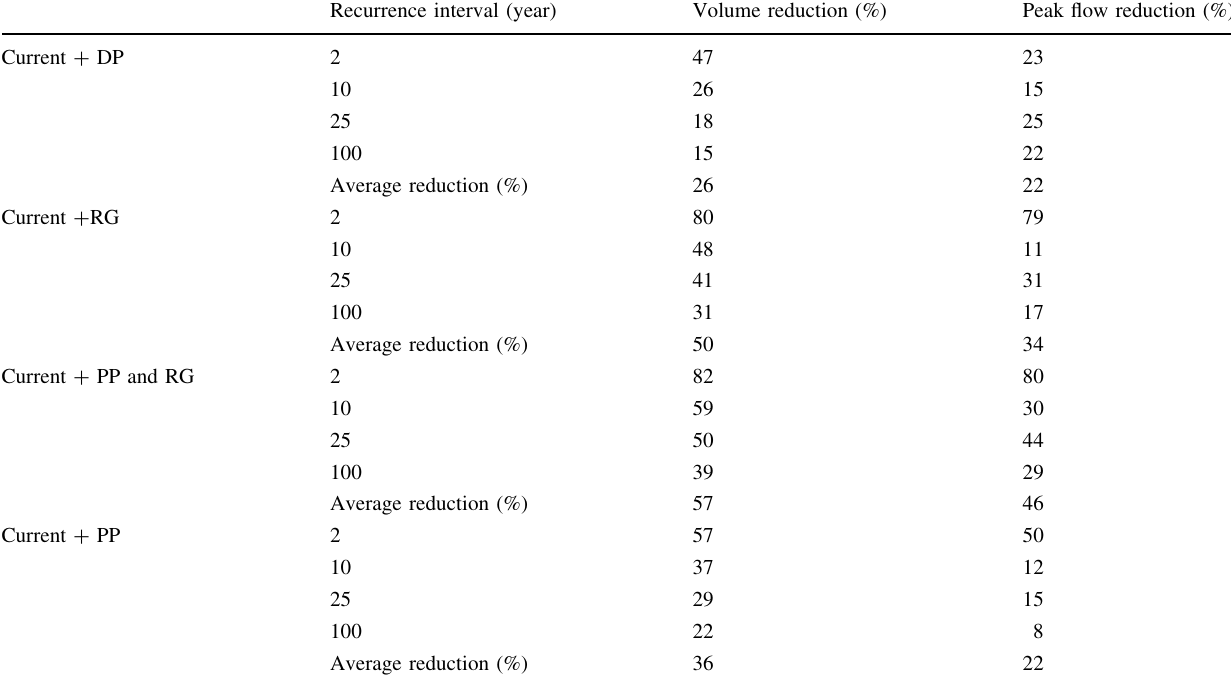
Table 4 Reduction percentages in runoff volumes and peak flow for different recurrence intervals and for the current and GI scenarios